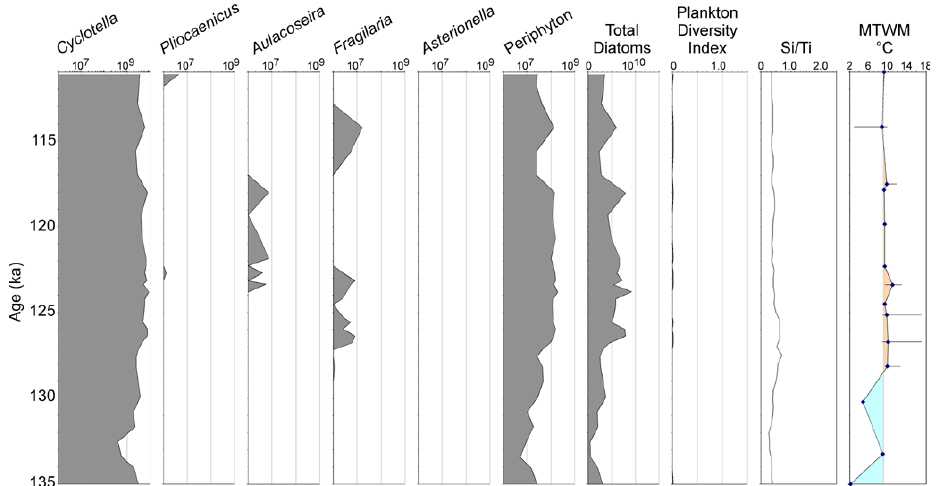
Fig. 4. Concentration (valves g − 1 ) of planktonic species, total periphyton, total diatoms, and plankton diversity (Shannon index) from 111 to 135ka. Other El’gygytgyn climate proxies from Melles et al. (2012) are included for comparison (see Fig. 3). 4